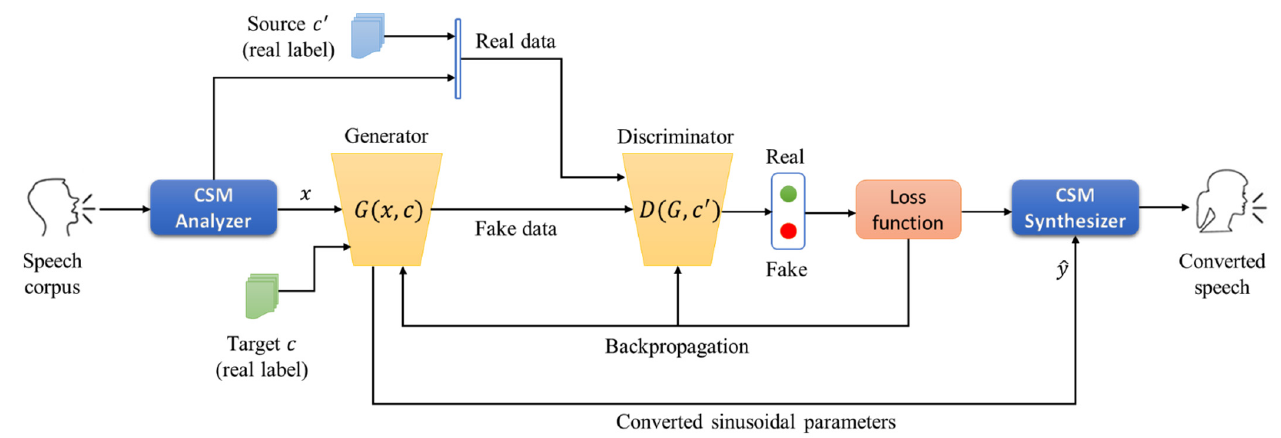
Figure 4. Overview of the developed VC based on the sinusoidal model, consisting of two training modules: a discriminator D and a generator G. D learns to distinguish between real and fake data and classify the real data into its corresponding domain. G tries to generate data indistinguishable from real data and classifiable as a target domain by D.